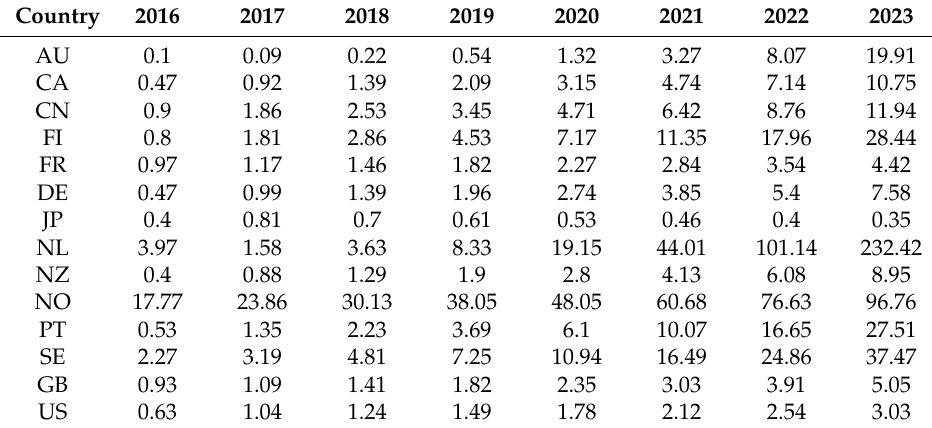
Table 9. The forecasted values of MSS.